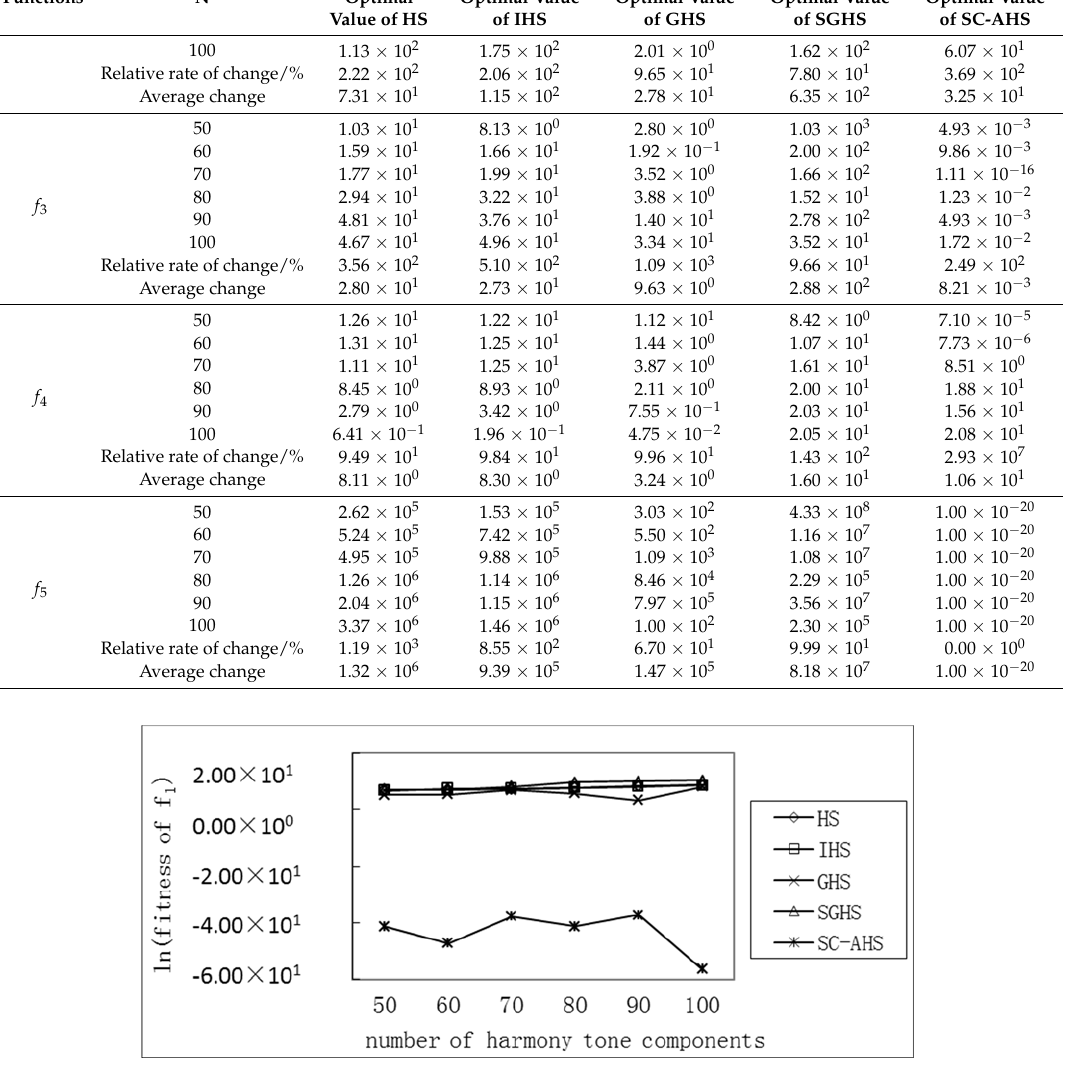
Figure 2. Comparison of the average optimum with different harmony tone components of the Sphere function.